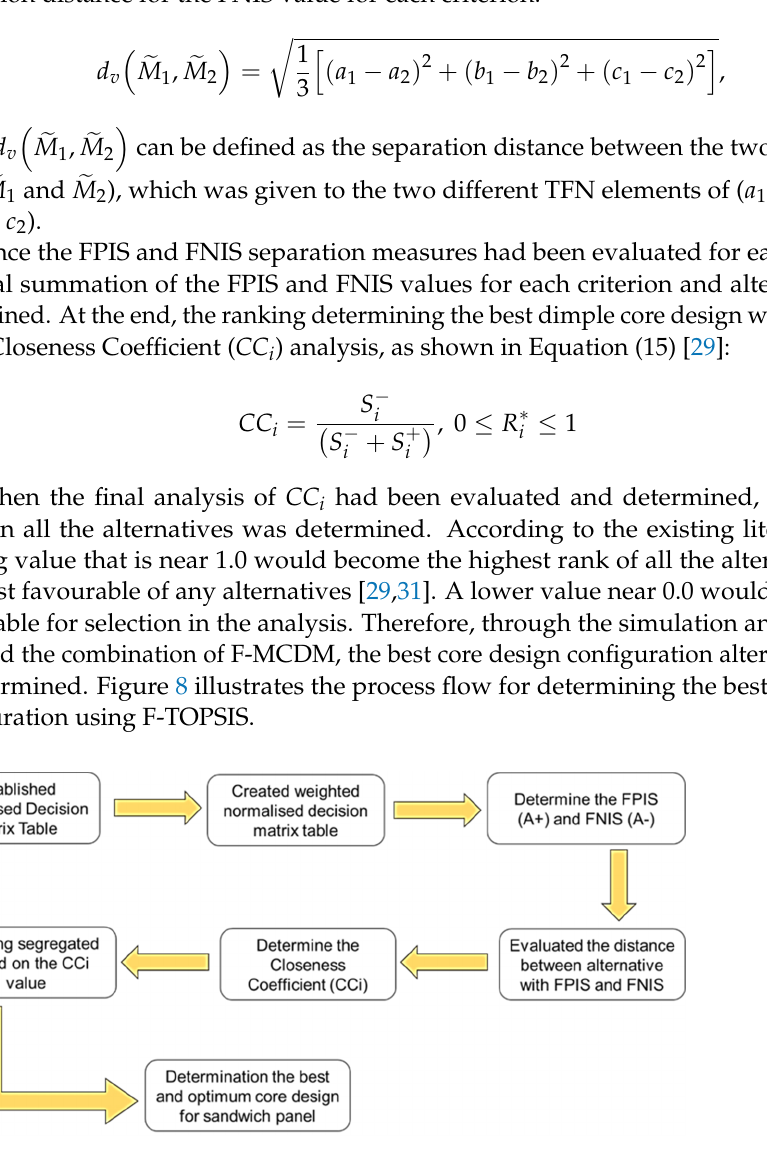
Figure 8. The steps to determine the best core design selection using the F-TOPSIS method.